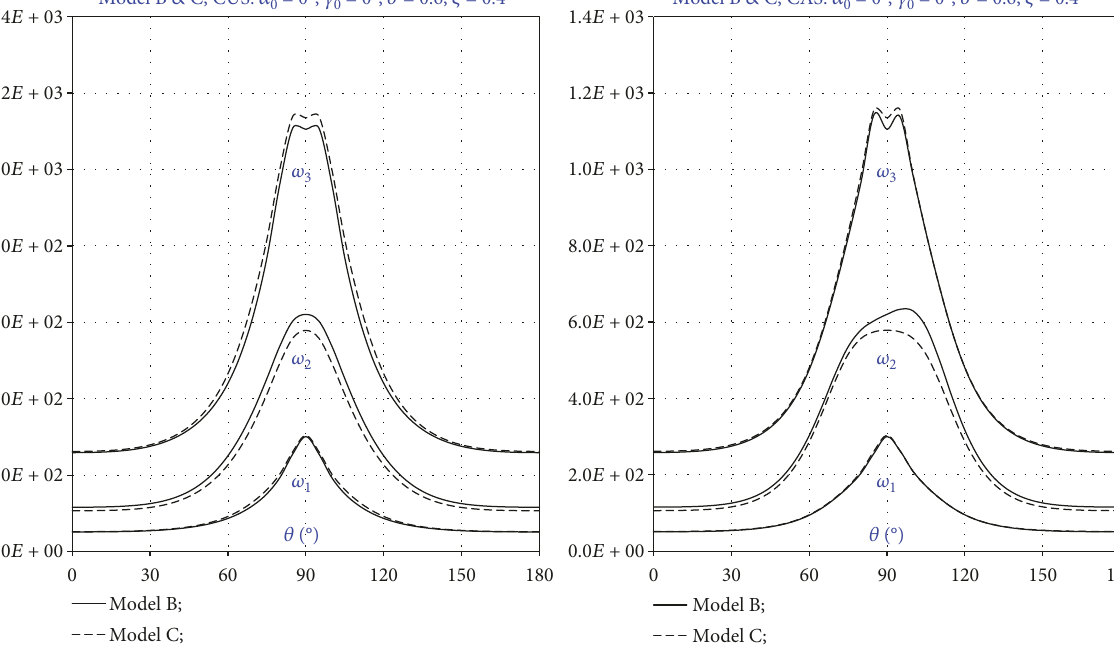
Figure 17: Eigenfrequencies of Model B and Model C for CUS and